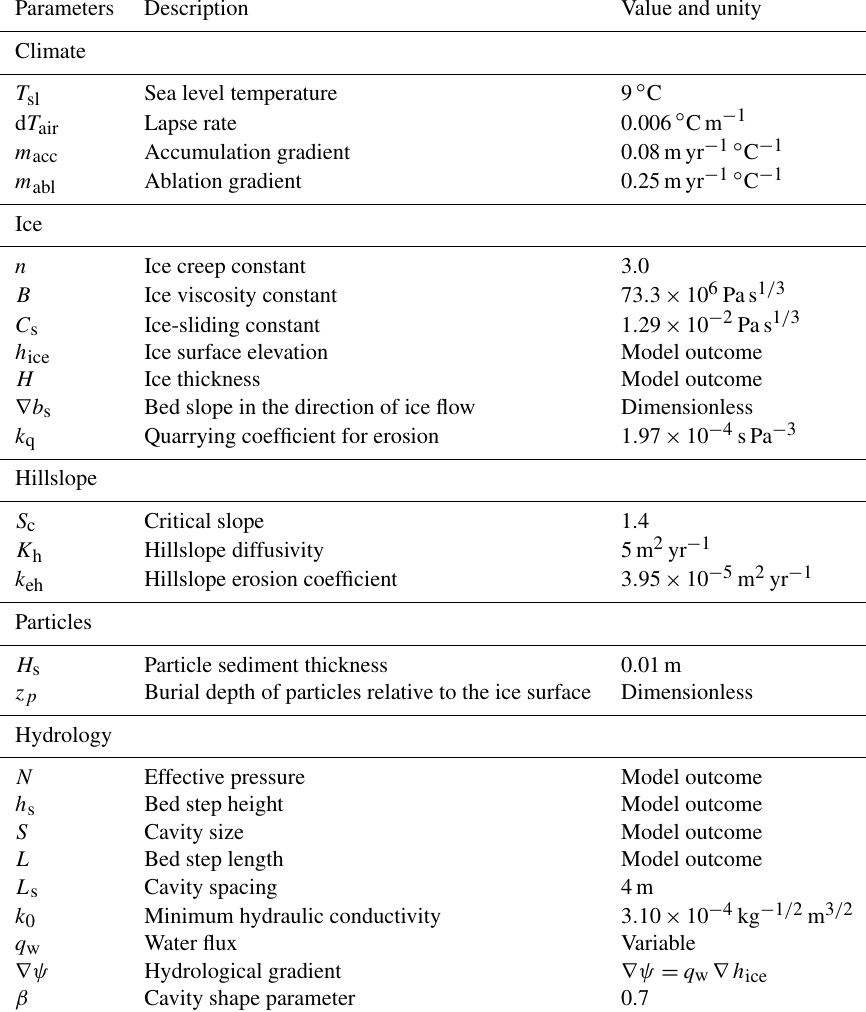
Table 1. List of parameters described in the